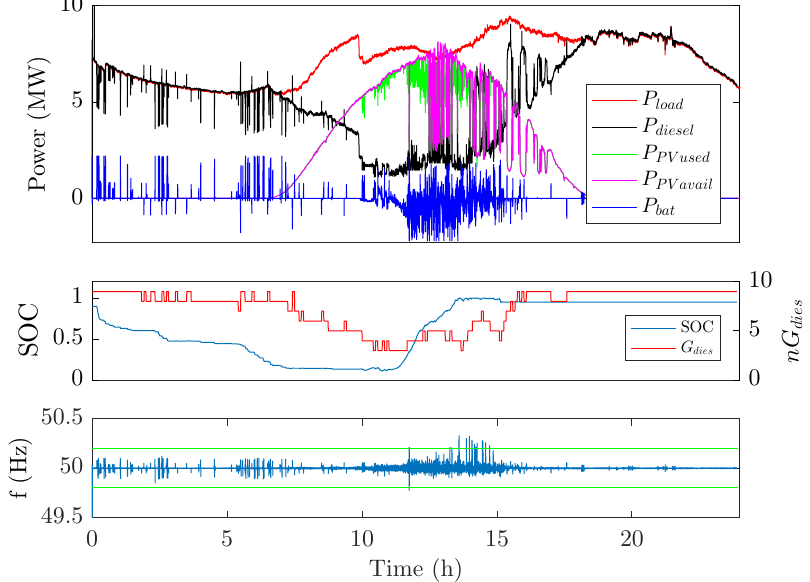
Figure 6. Simulation results for the first scenario (high PV power variability after the